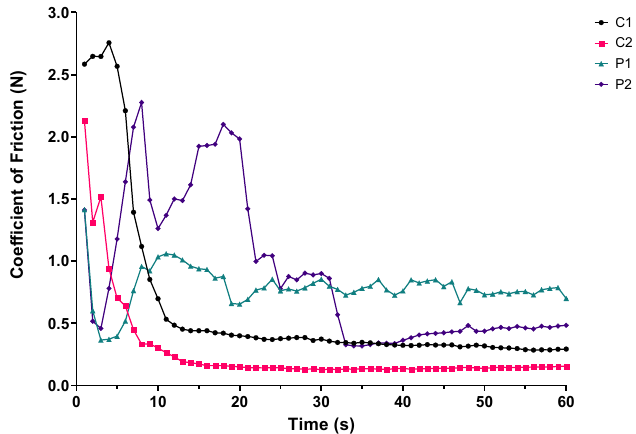
Figure 4. Coefficient of friction–time plot of ODF samples positioned between the upper acrylic palate and silicone tongue during BTM tribological testing ( n = 3) . Calculation of mean coefficient of friction over the duration of experimentation